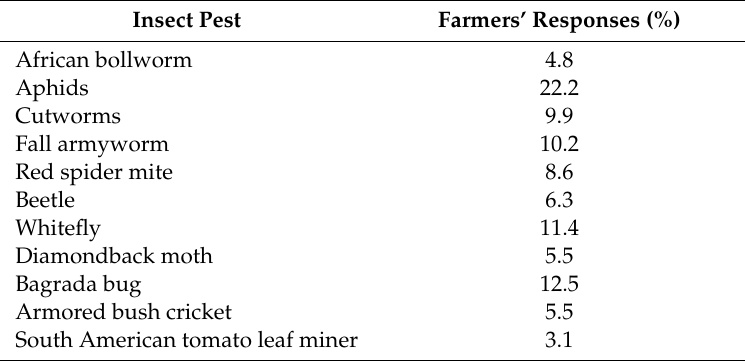
Table 3. Perceptions of respondents regarding the prevalence of insect pests in Vhembe District.